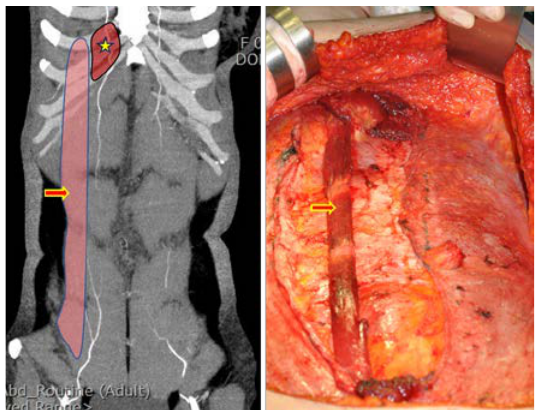
Figure 2. Preservation of the rectus abdominis muscle. ( Left ) Muscles can be preserved in the area marked light red and indicated by the arrow. The rectus muscle is removed from the red area indicated by the star. ( Right ) The width of the preserved rectus muscle is about 2–3 cm.